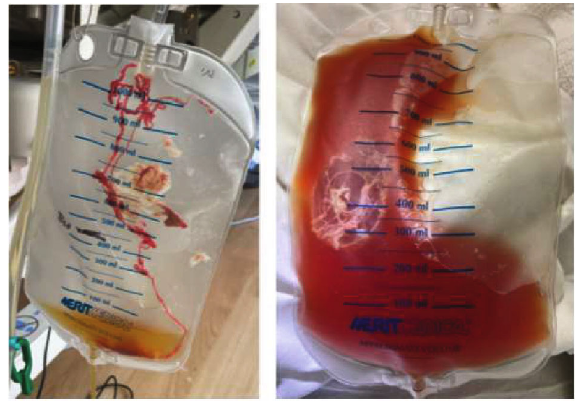
Figure 4: Pericardiocentesis with immediate removal of 350 cc cloudy, tan-brown, sanguinous fl